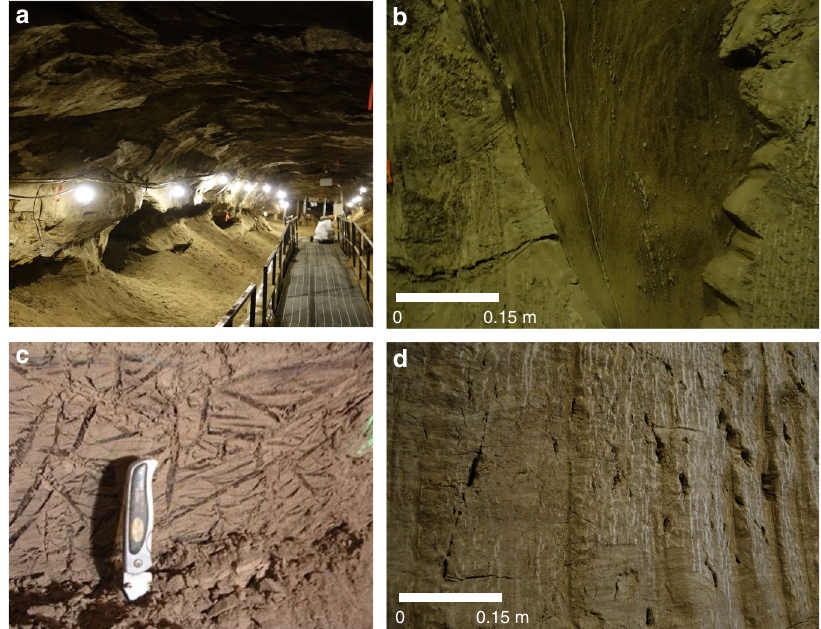
Fig. 3 Photographs representing different surfaces present in the tunnel and their differential sublimation features. a The main tunnel showing the walls 52.5 years since excavation. Note the dark shadowy regions are where massive ice wedge features have retreated more than a meter into the wall. The roof and upper wall material represent pristine 52.5-year exposures. b Differential sublimation of ice wedge ice (dark color) and ice cemented silt (dark tan) in a wall exposed to sublimation for 5 years. c Reticulate-chaotic ice cryostructure with areas of ice (angular dark features retreated inward) in ice cemented silt. This exposure is three years old. d A 5 year old exposure exhibiting differential sublimation of segregated, lenticular-layered, and lens ice features